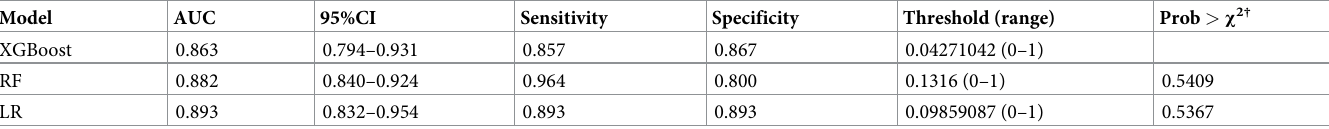
Table 3. Predictive performance of the models built for each audio file for predicting